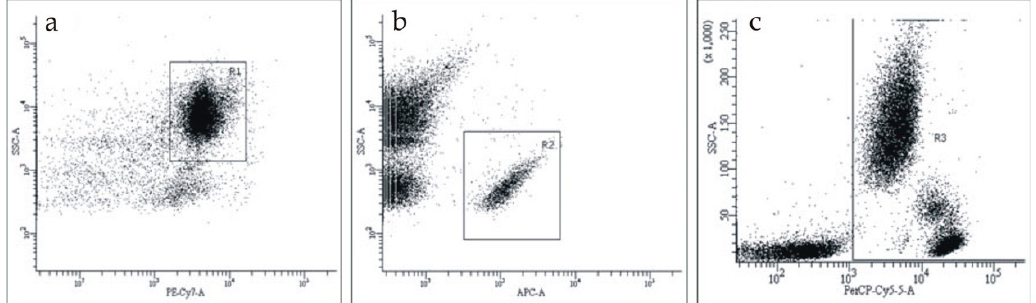
Figure 1. The gating of cells on the flow cytometry diagrams. ( a ) the gating of CD235a-PE-Cy7-positive events (erythrocytes), gate R1; ( b ) the gating of CD41-APC-positive events (platelets), gate R2; ( c ) the gating of CD45-PerCP-Cy5.5-positive events (leukocytes), gate R3. SSC-H—side scatter.